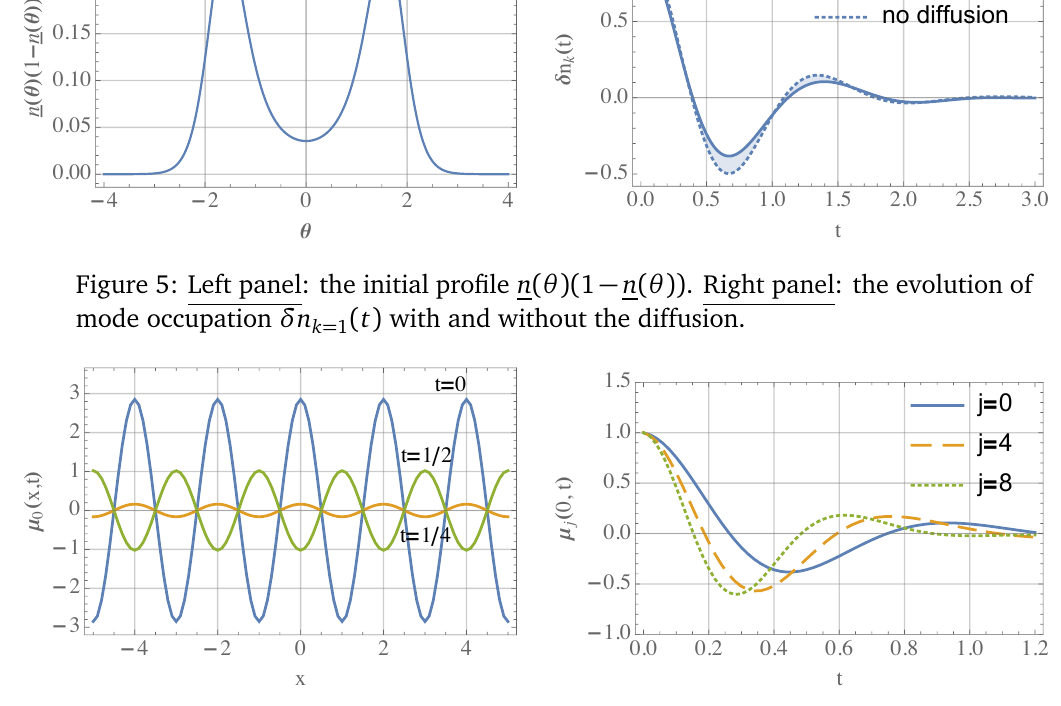
Figure 6: Time evolution for the initial profile (23). Left panel: the zeroth moment µ ( t , x ) shows steady collapse of the initial spatial profile. Right panel: local mo- 0 ( x = 0, t ) cease to zero with the j = 0 moment being the ments of the distribution µ j